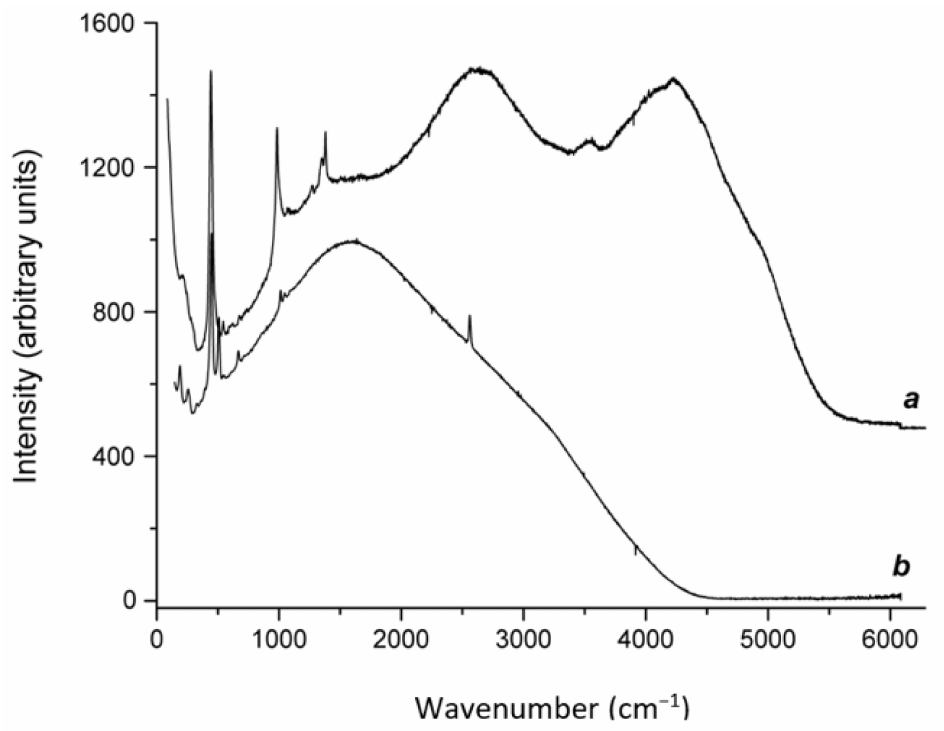
Figure 11. Uncorrected Raman spectra of ( a ) red–orange sulfhydrylbystrite (Sample 12) and ( b )